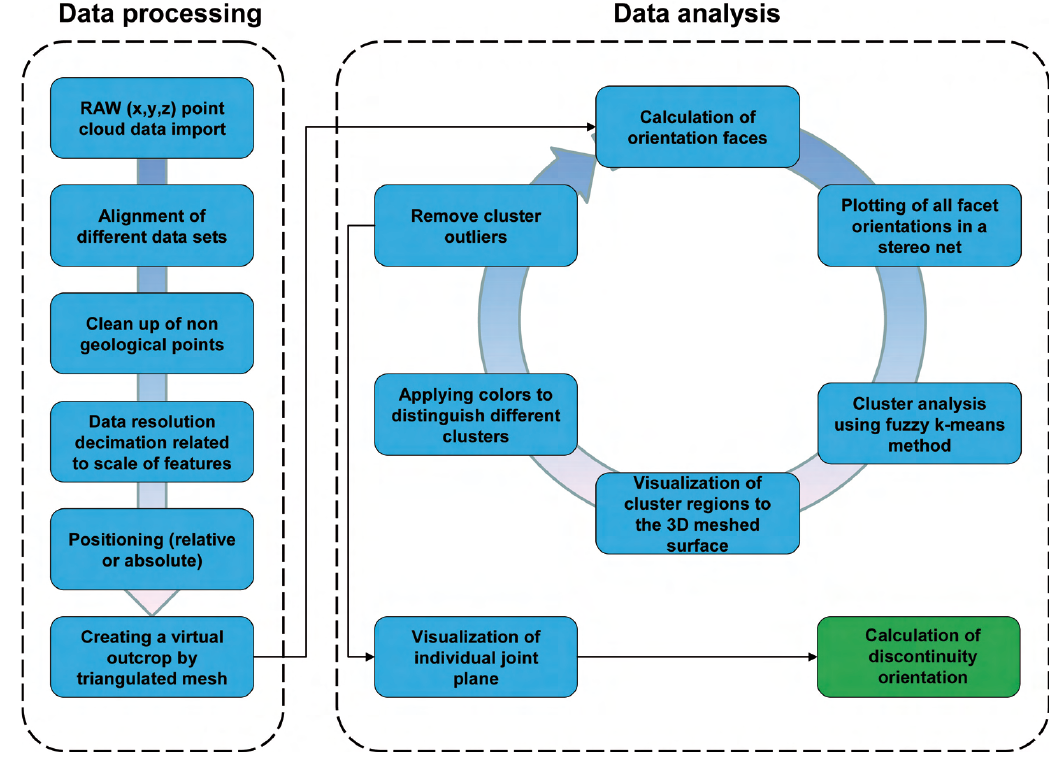
Fig. 6. Workflow describing the processing of TLS data for discontinuity analysis of rock